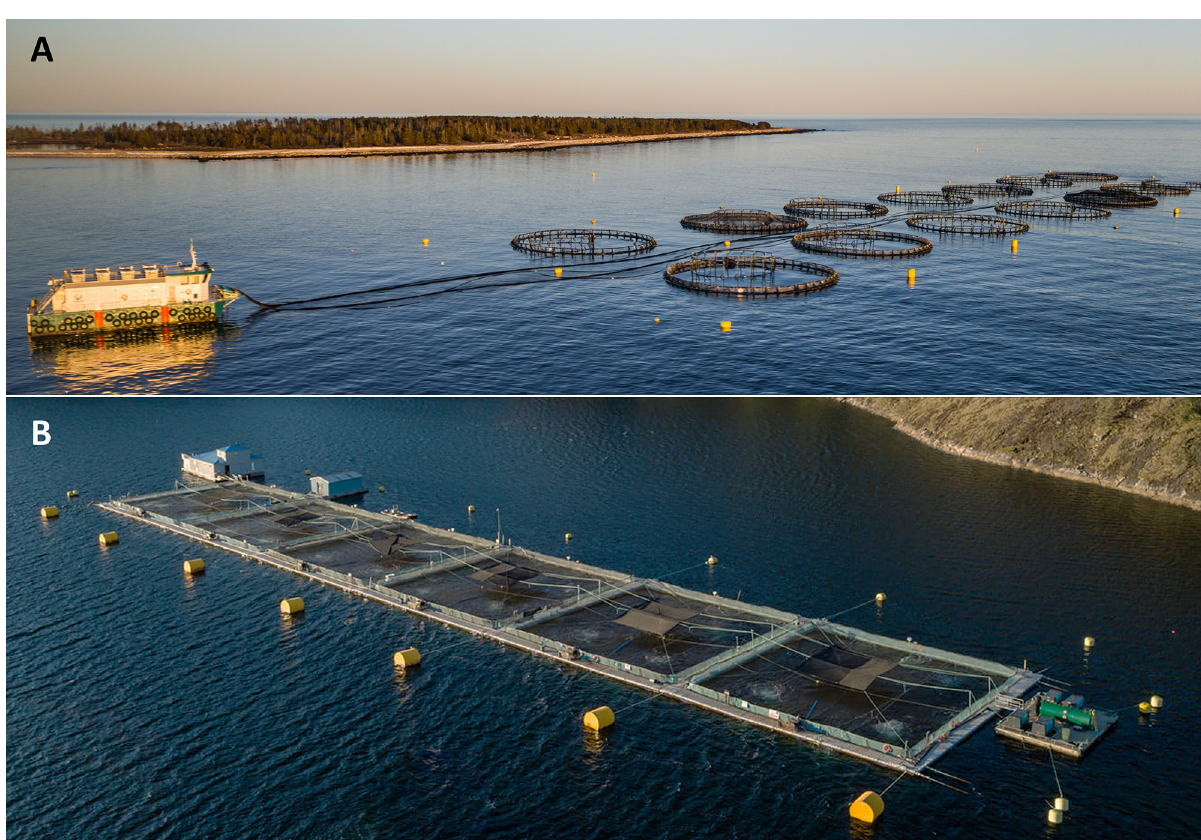
Fig. 4. Examples of large, modern finfish farms. (A) Feed barge delivering feed to circular open net-pens via a series of pipes and blowers (photo: Cooke Aquaculture). (B) Farm with square net-pens using a similar feed system; however, there are also oxygen aeration units, and storage and accommodation facilities (photo: Grieg